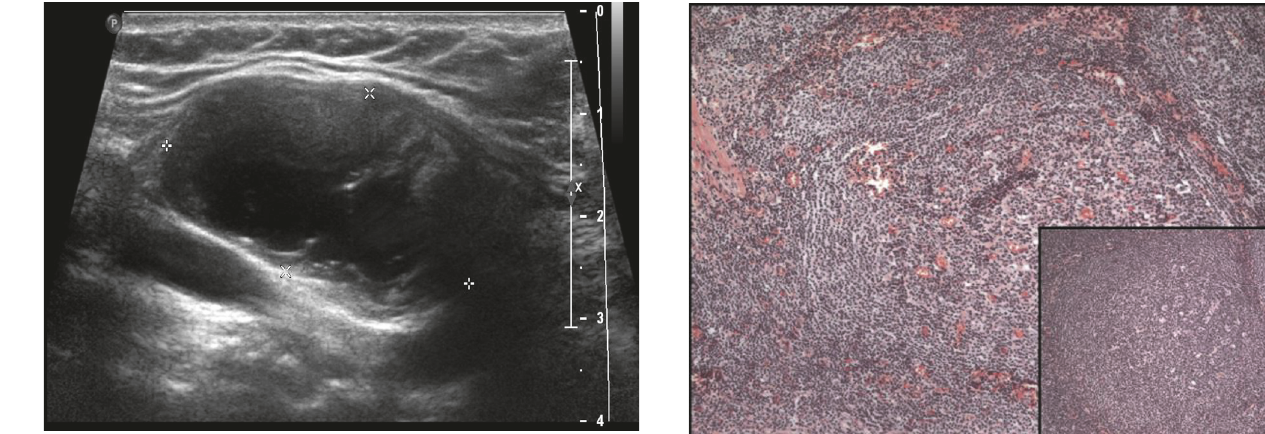
ryngeal lymph node (insert), stained with Hematoxylin and Eosin (100x).